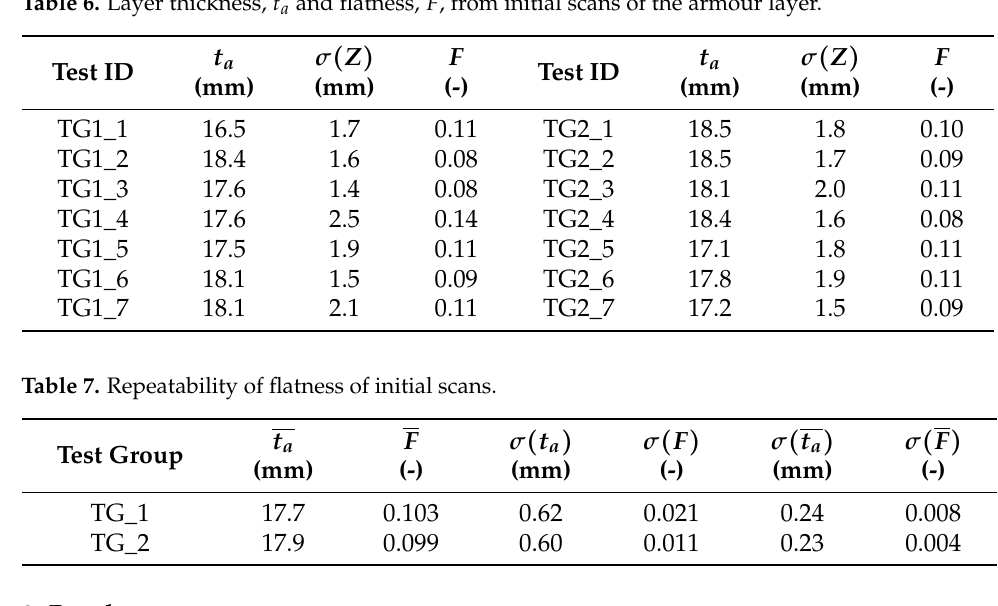
Figure 8. Sketch of flatness of armour layer thickness. Table 6. Layer thickness, t a and flatness, F , from initial scans of the armour layer.